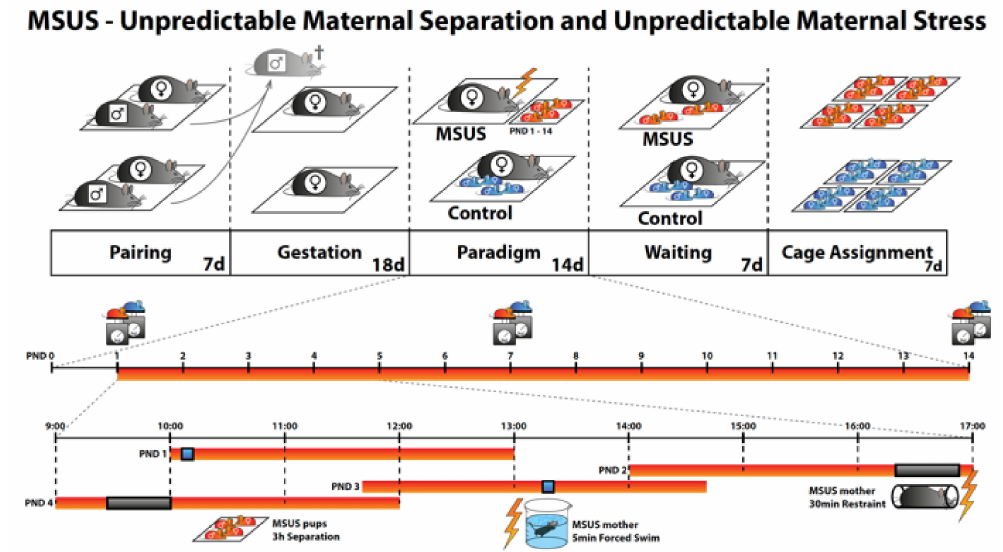
Figure 7. MSUS (unpredictable maternal separation and unpredictable maternal stress) is a mouse model of early life stress. Naïve males are mated with naïve females for 1–7 days, then males are removed. Dams gestate for about 21 days in normal conditions until delivery. The MSUS paradigm (red bar in the timeline) starts at postnatal day 1 (PND1) and lasts until PND14. During MSUS, pups are unpredictably separated from their mothers for 3 h each day at di ff erent times of the dark cycle (lights o ff from 8 a.m. to 8 p.m.). During separation, the mother is stressed unpredictably by forced swim or restraint as shown in the timeline at the bottom. Pups and dam are left undisturbed from PND15 until weaning at PND21. Gray mice are naïve without any previous stress exposure. Blue pups are controls without any stress exposure. Red pups are exposed to